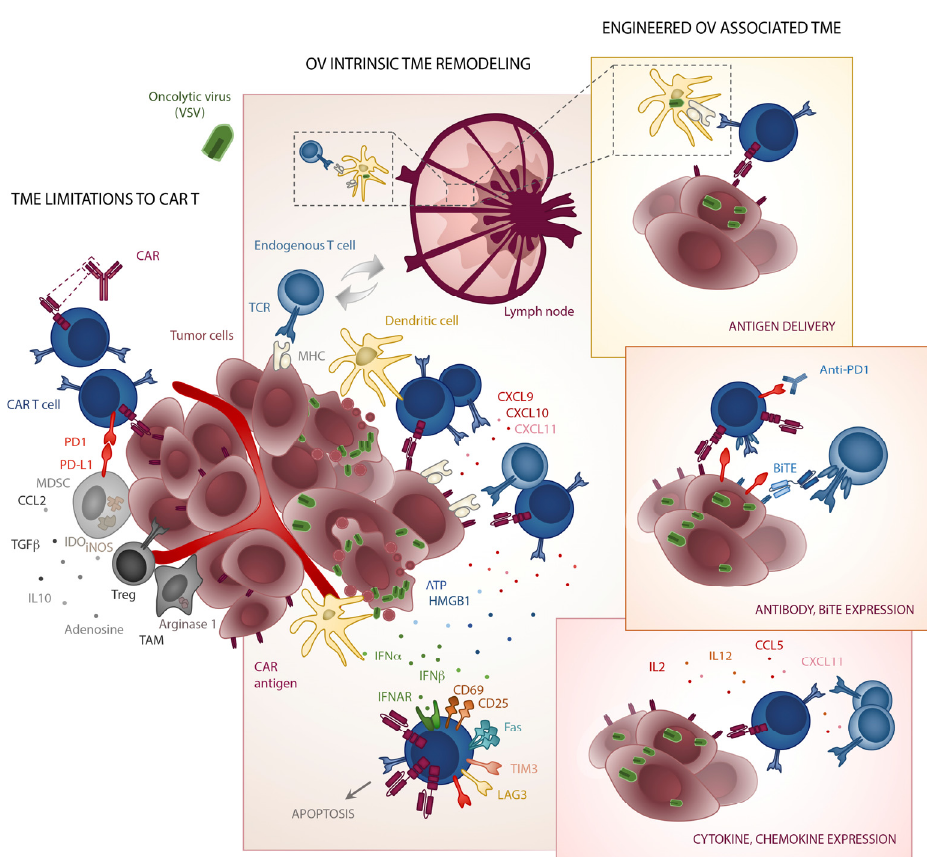
Figure 1. Strategic combination of oncolytic viruses with CAR T cells. The TME presents many immunosuppressive barriers to CAR T trafficking (high levels of CCL2, low levels of T cell chemotactic chemokines), as well as functionality through cytokines (TGF β and IL10), metabolic dysregulation (arginase 1, inducible NO synthase (iNOS), indoleamine 2,3-dioxygenase (IDO), and CD39 and CD73 production of adenosine), and inhibitory ligands (PDL1 etc.). Many of these factors are expressed by tumor associated macrophages (TAMs), myeloid derived suppressor cells (MDSCs), regulatory T cells (Tregs) or the tumor cells themselves. Viral infection and oncolysis of tumor cells lead to the production of type I interferons (IFNs), danger-associated molecular pattern molecules such as HMGB1 and ATP, and CXCL9, 10, and 11 which in turn recruit additional T cells and dendritic cells. Exposure to high level type I IFN can also have inadvertent negative consequences for CAR T cells leading the upregulation of various inhibitory receptors including PD1, TIM-3 and LAG-3, as well Fas, leading to apoptosis. In contrast to some of these intrinsic properties, OVs can be armed with transgenes such as cytokines (IL2, IL12), chemokines (CCL5, CXCL11), checkpoint blocking antibodies (anti-PD1, etc.), BiTEs (EGFR, etc.) or the CAR antigen itself (CD19,